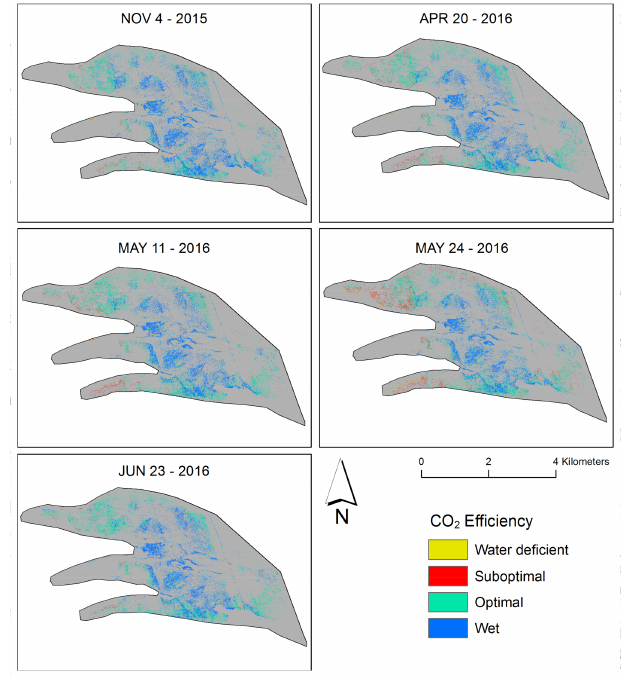
Figure 10. Spatial patterns of CO 2 uptake efficiency for hollows over five dates at the Mer Bleue peatland.